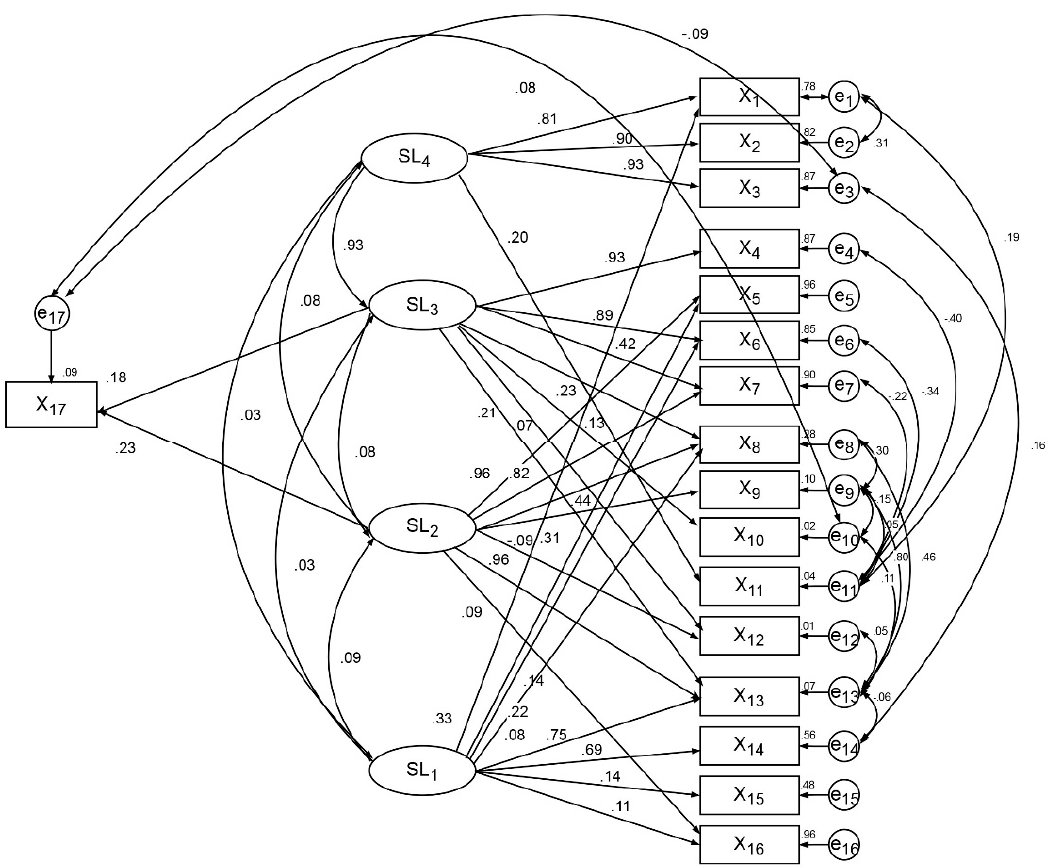
Figure 5. Path diagram of marine accidents formation using structural equation model simulation.